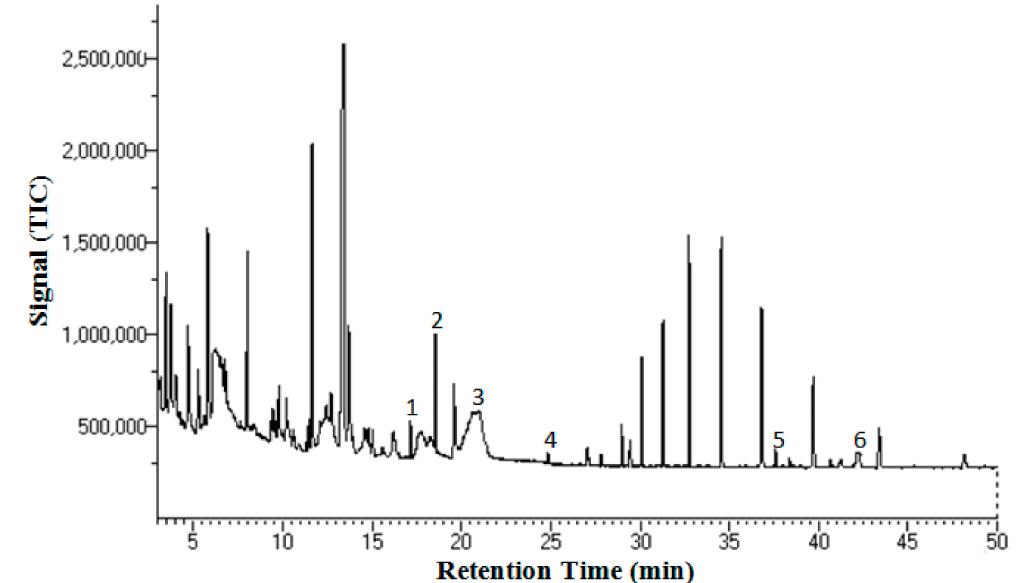
Figure 1. Total ion GC/MS chromatogram of a Salvia miltiorrhiza herbal extract obtained by subcritical water extraction (SBWE) at 150 ◦ C for 30 min. Peak identification: 1, protocatechualdehyde; 2, propyl paraben (internal standard); 3, caffeic acid; 4, ferulic acid; 5, tanshinone IIA; and 6, tanshinone I.